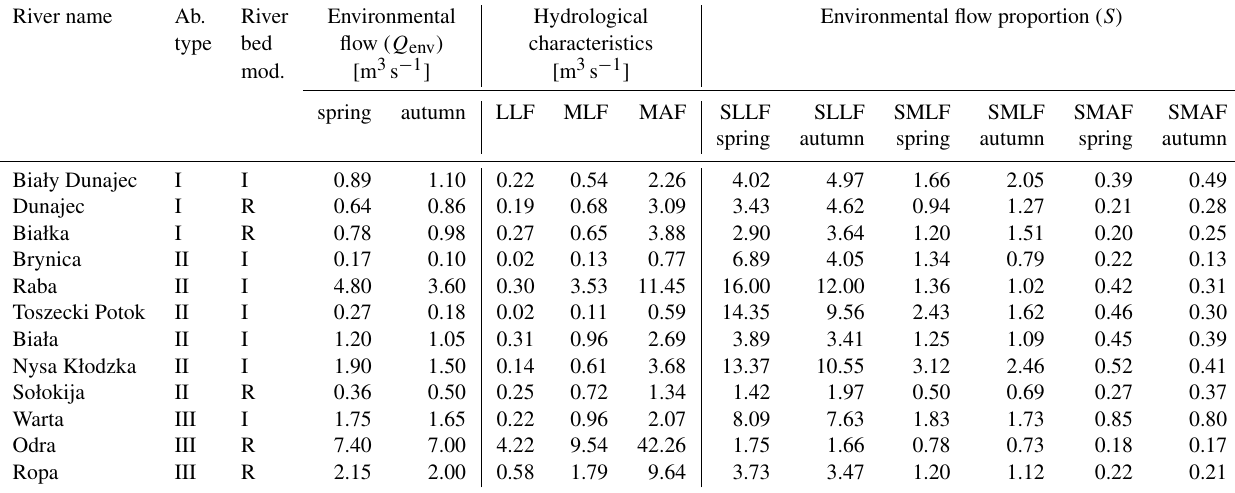
Table 4. Environmental flow and flow proportion ( S ) in different abiotic and bed modification types (I – incision, R – redeposition) of 12 mountainous rivers.